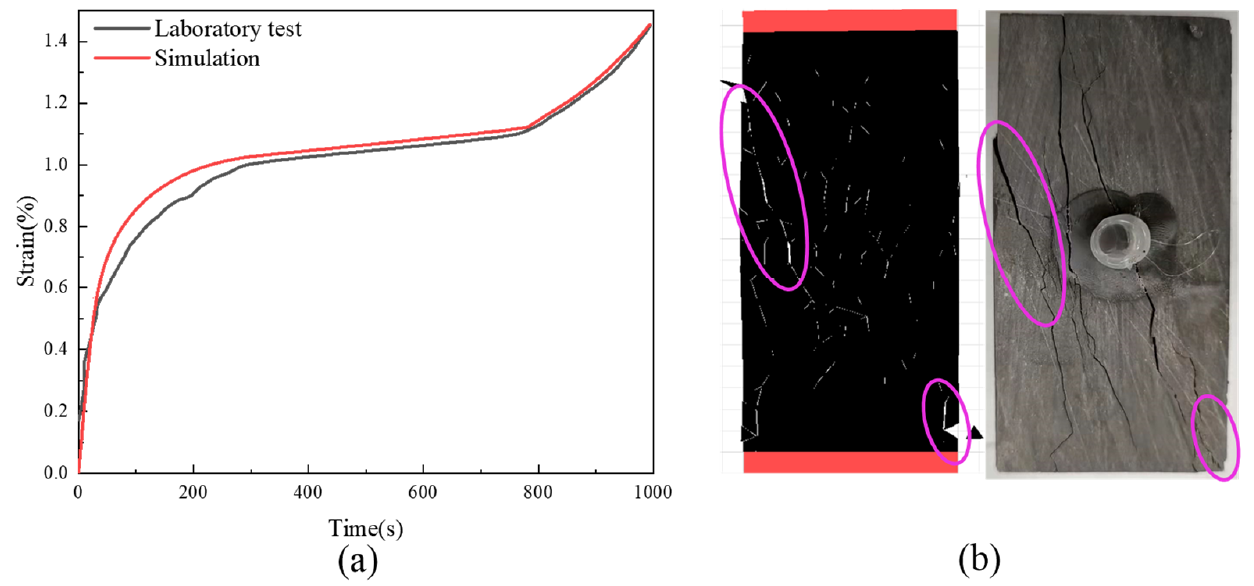
Figure 7. Rheological parameter calibration. ( a ) matching between simulated and test curves; ( b ) matching between simulation and test damage results.